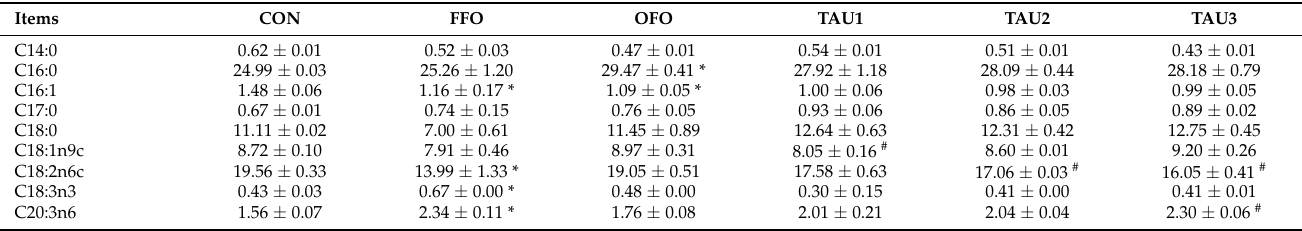
Table 4. Serum fatty acid profile in all experimental groups of mice 1